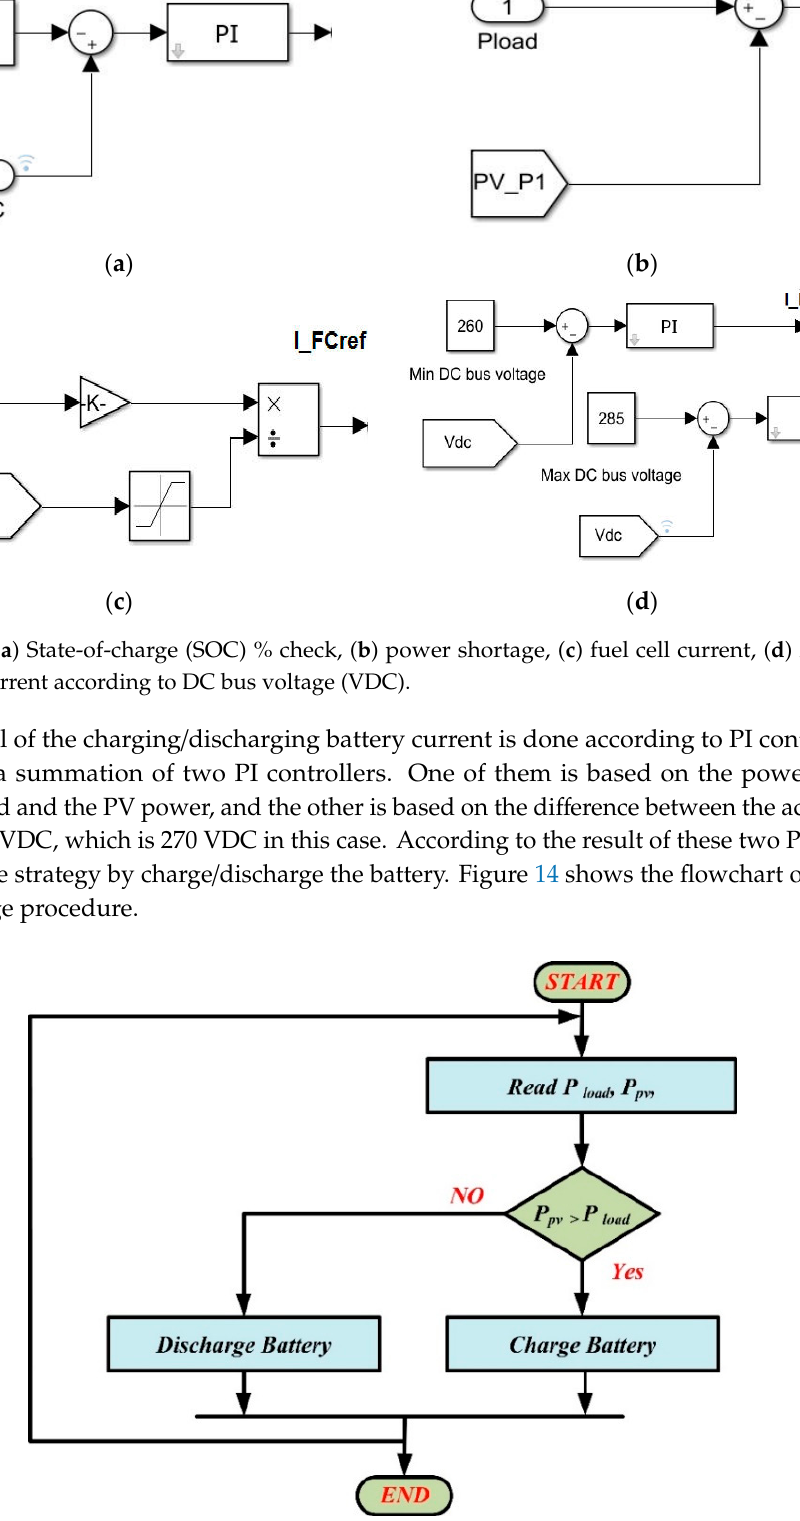
Figure 14. Battery charge/discharge flowchart according P load and P pv .